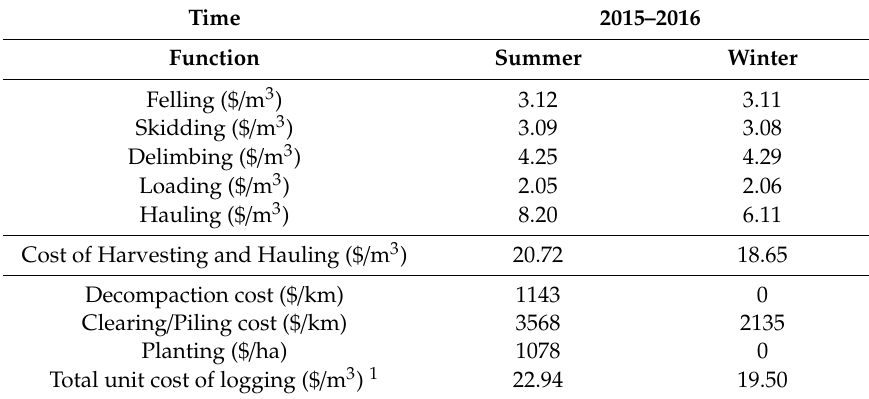
Table 2. Unit prices for each phase of the logging operations in 2015 – 2016 with hauling directly to the mill.